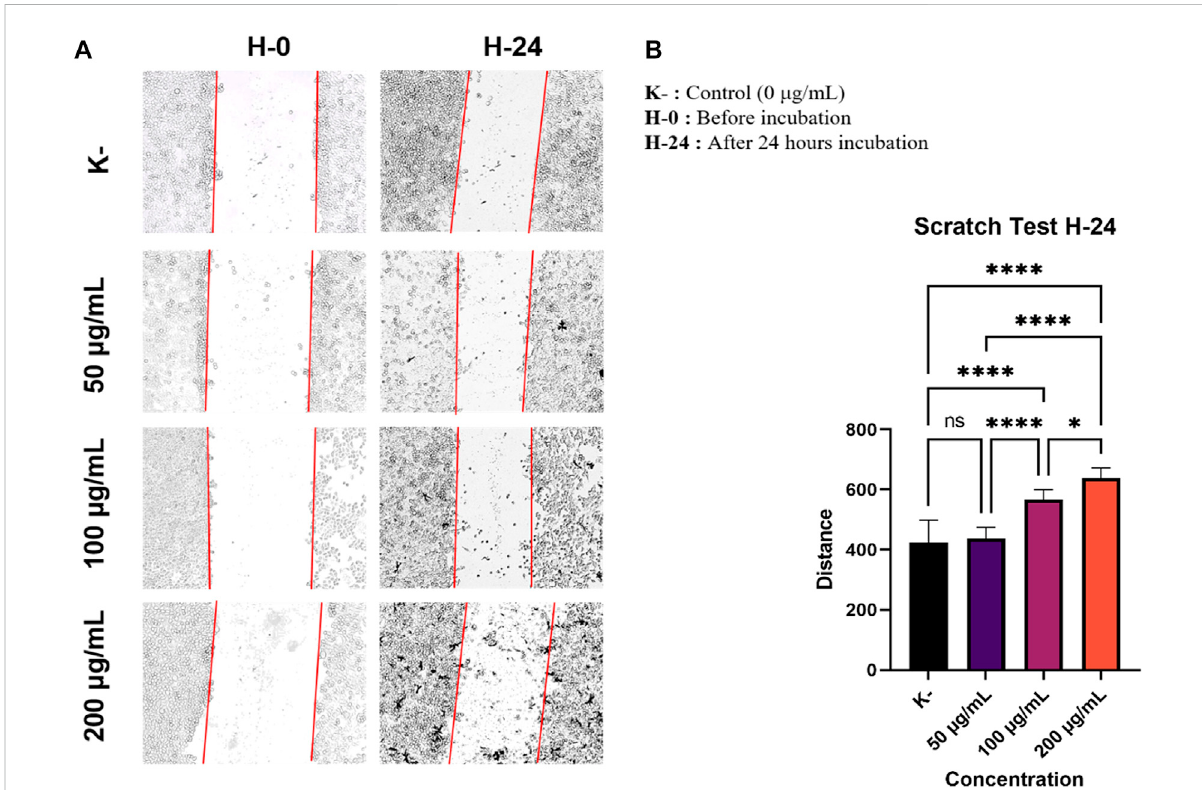
Asthedoseof C.racemosa increases, thedistancebetweencells getswider. (A) Morphology ofHeLacellsafter beingtreated with C.racemosa extract at various doses for 24 h (B) The stroke width of various doses of C. racemosa extract calculated using the ImageJ ImmunoRatio application, thedataarepresentedintheformofmean±standarddeviation,* p < 0.05;**** p < 0.0001;ns:notsigni fi cant(One-wayANOVAandTukey ’ smultiple comparison